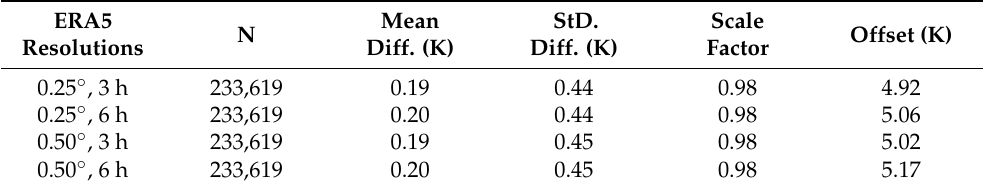
Table 3. Statistical parameters of the differences in SST skin derived from the Sentinel-3A SLSTR sensor and the ECMWF ERA5 atmospheric model (SST SLSTR –SST ERA5 ), for Sentinel-3A SRAL cycle 21.